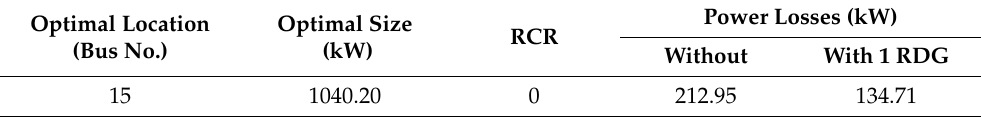
Table 5. Results for installing a single RDG on IEEE 33-bus test distribution systems.